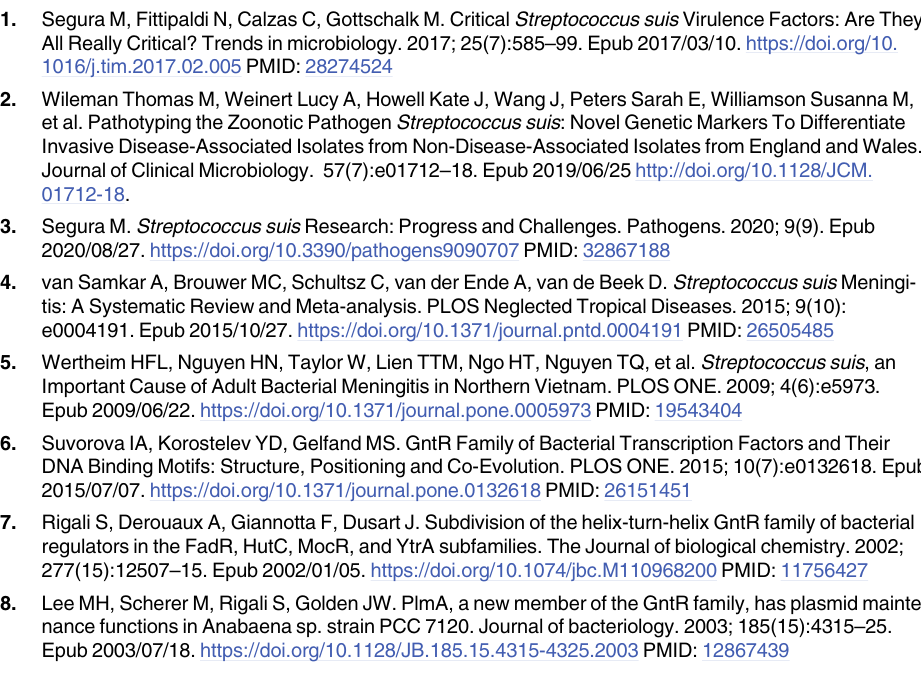
S4 Table. Primer used in this study. (DOCX) S1 Data. Excel spreadsheet containing the numerical data and statistical analysis for Figure panels 2A, 2B-2F, 2H-2I, 3E, 3G, 4A, 4B, 4C, 4D, 4E, 5A, 5B-5C, 5D, 5E, 5F, S3, S4B, S5, and